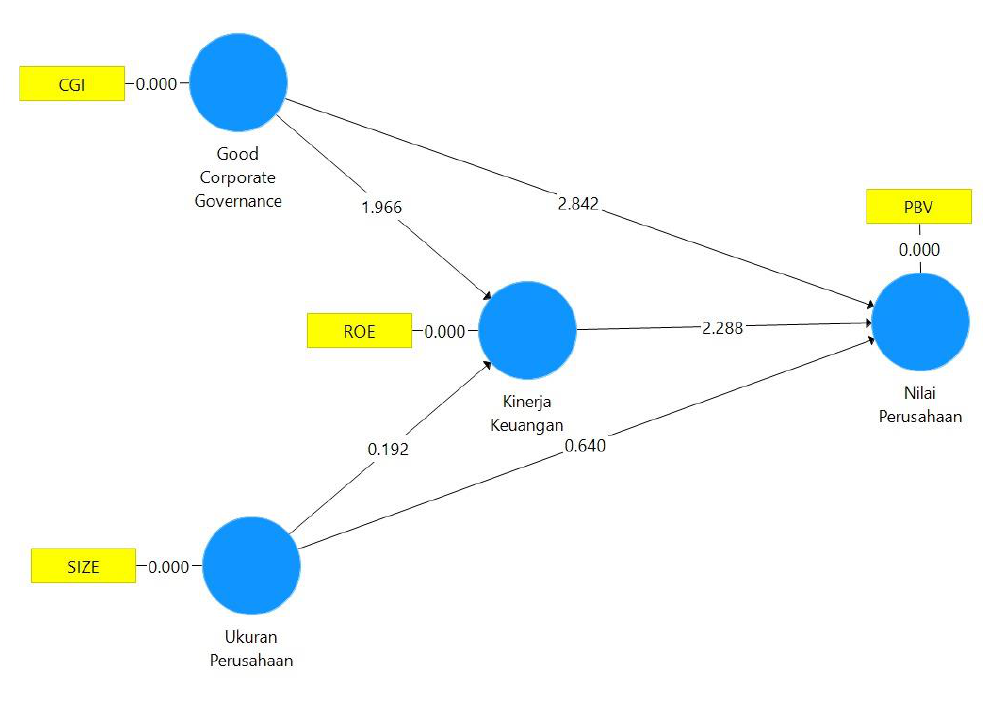
Figure 2 : PLS Bootstrapping Output; Source: SmartPLS Output Results, 2022.